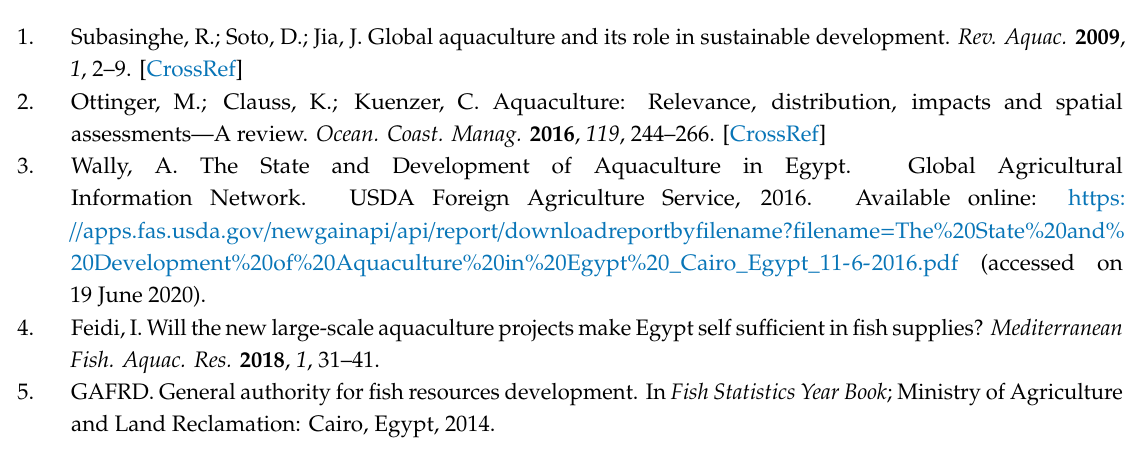
Figure S1: Fish mortalities on water surface and on the pond banks. Figure S2: Clinical signs of freshly dead O. niloticus fish; hemorrhages on the skin, fins and vent opening, loosened scales with deep skin ulceration and fin erosions, distended abdomen and exophthalmia. Figure S3: Agarose gel electrophoresis of Aeromonas isolates from di ff erent sources using 100-bp molecular standard size ladder. Table S1: The number, ranges of lengths, and weights of collected tilapia fish during the study period (March–August 2017). Table S2: Phenotypic characterization results of Aeromonas species retrieved from water and fish samples in the examined fish